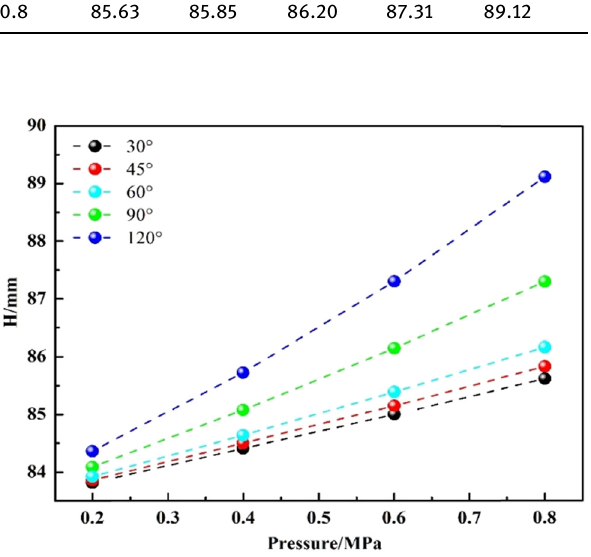
Figure 12: Relationship between pressures and maximum deforma - tion height of bump at di ff erent cord angles.